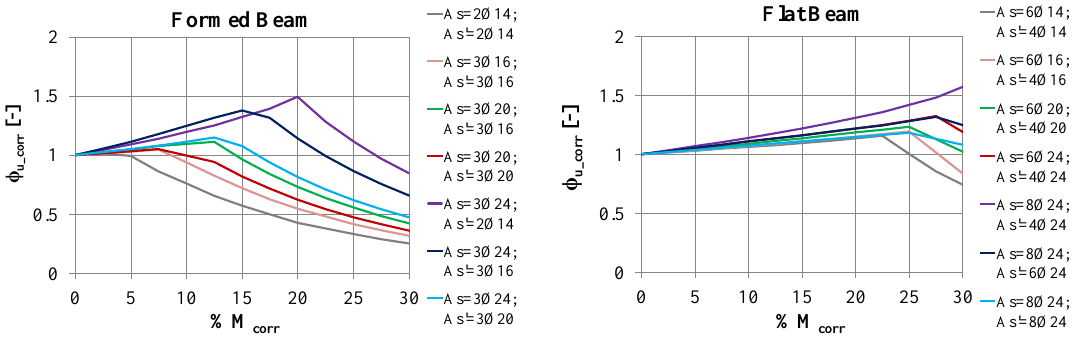
Figure 10. Nondimensional ultimate curvature after the pitting corrosion: differences between the flat and the formed beams.